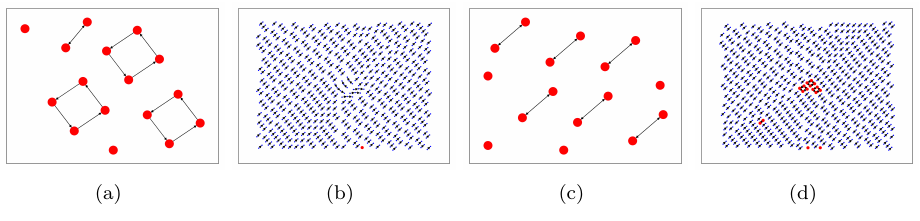
Figure 3: The directed graphs G in Algorithm 2 : (a) GIFT-64 , (b) GIFT-128 , (c) AES , and (d) MIDORI-64 .